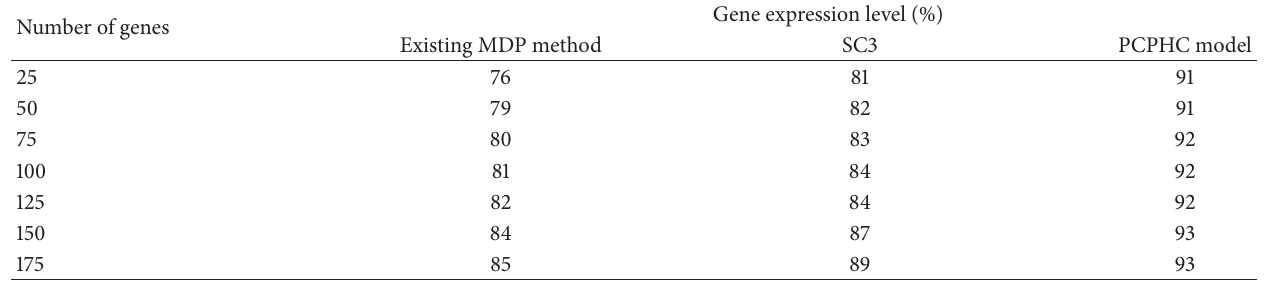
Table 5: Tabulation of gene expression level (using yeast gene expression dataset).